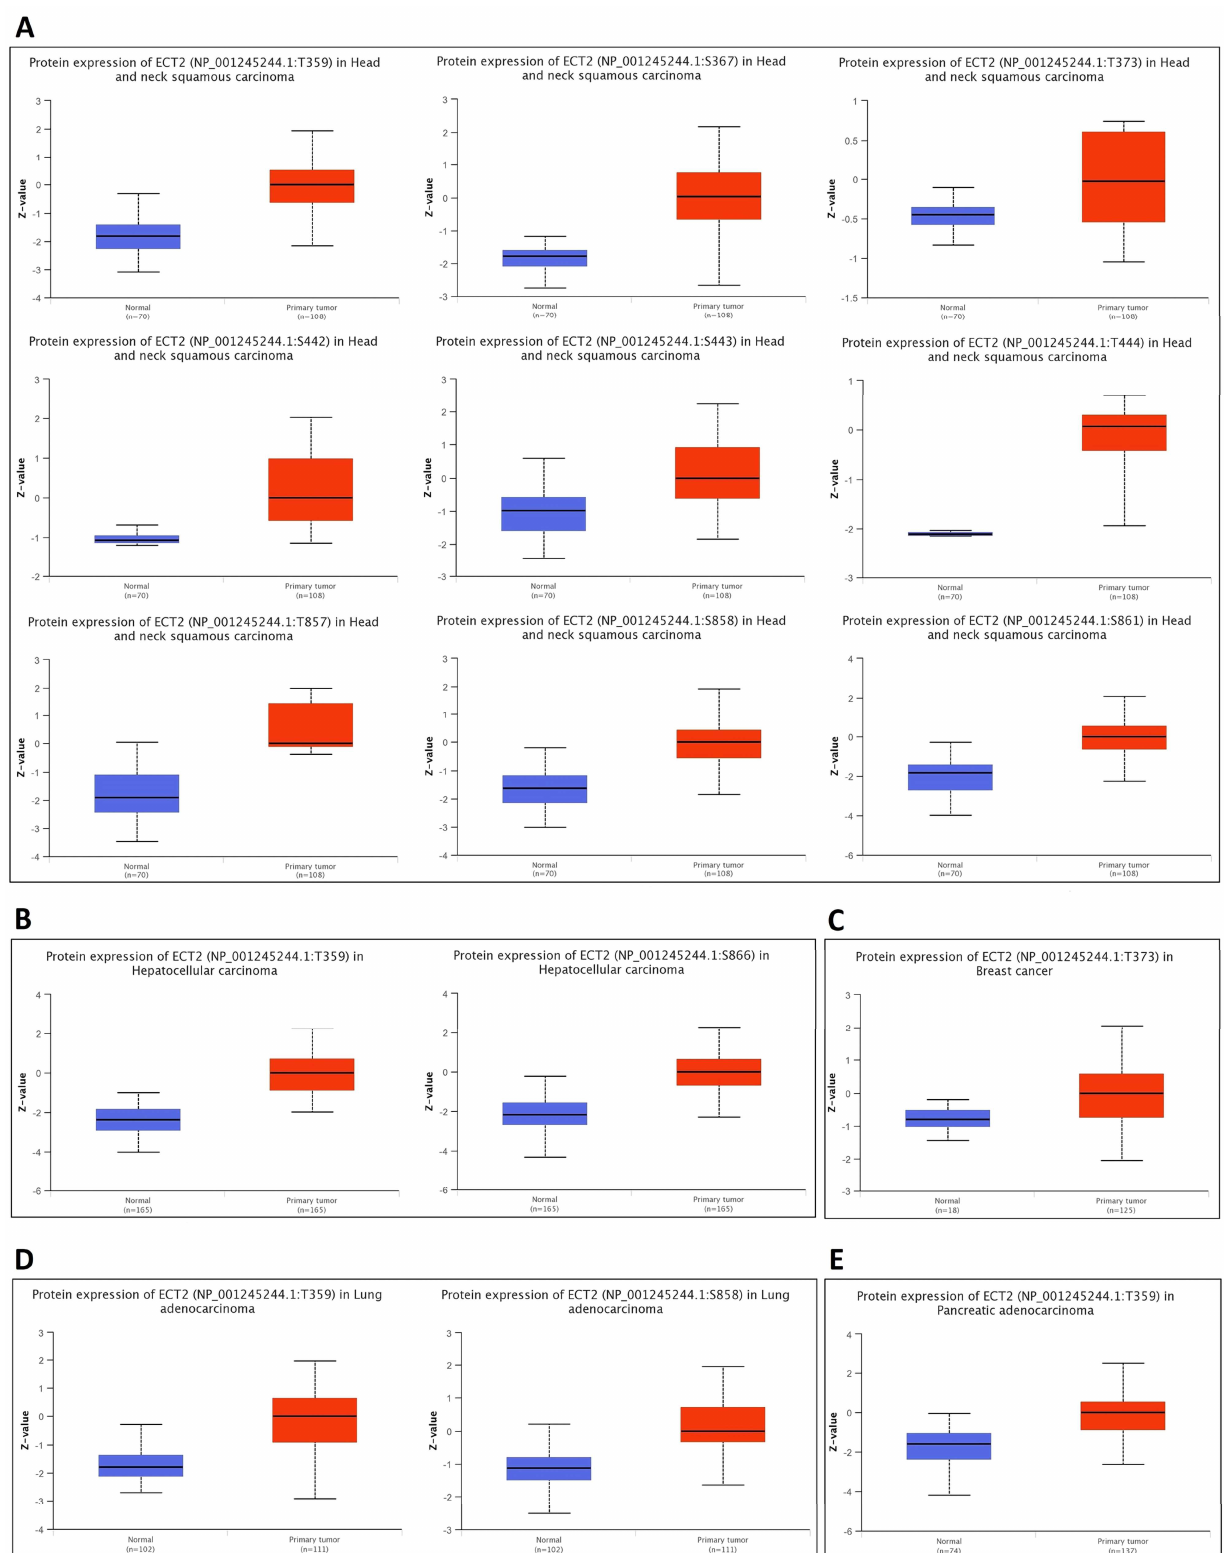
Figure 7. Differential phosphorylation analysis of ECT2 in tumor samples versus normal ones.